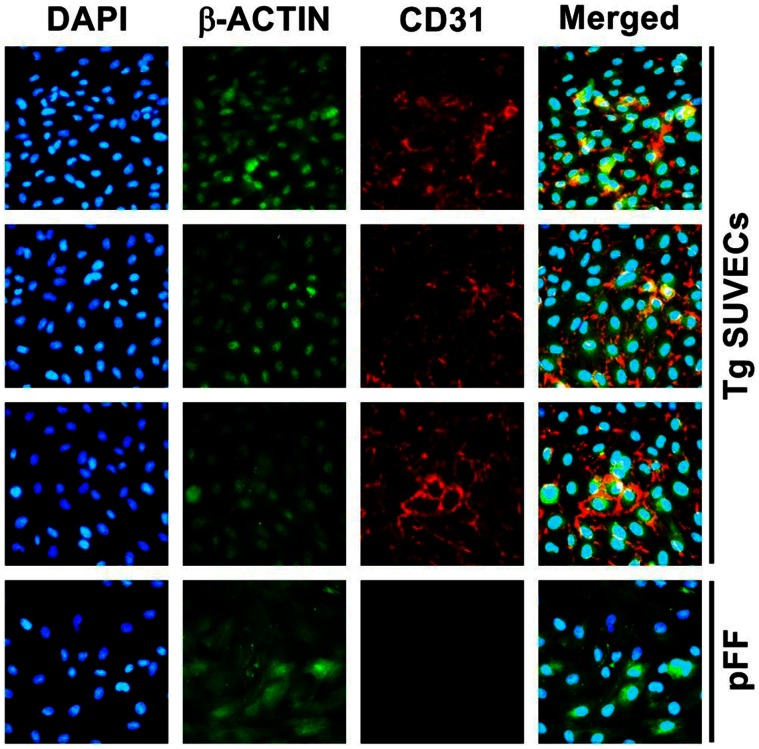
Primary Swine Umbilical Vein Endothelial Cells from triple-transgenic pigs.Primary cultured SUVECs were characterized by immunostaining with CD31 (red) and actin filaments (green), and the nuclei was counterstained with DAPI (blue).